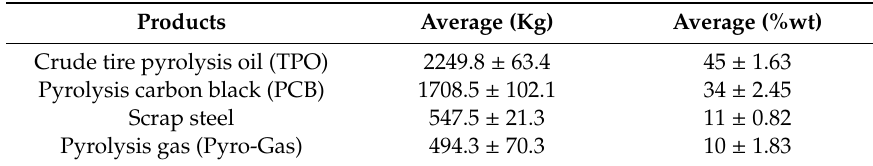
Table 2. Yield of pyrolysis